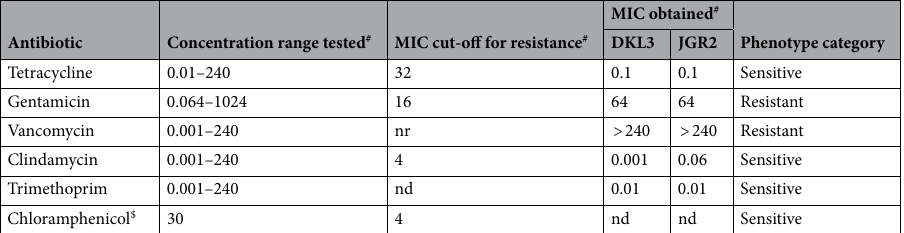
Table 2. Antibiotic minimum inhibitory concentrations and resistance of L. plantarum DKL3 and JGR2. Cut-off values are based on the guidelines given by European Food Safety Authority (EFSA), 2012. # Values in mg/l. $ Sensitivity was determined by disc-diffusion method and MIC not determined (nr: not required; nd: not